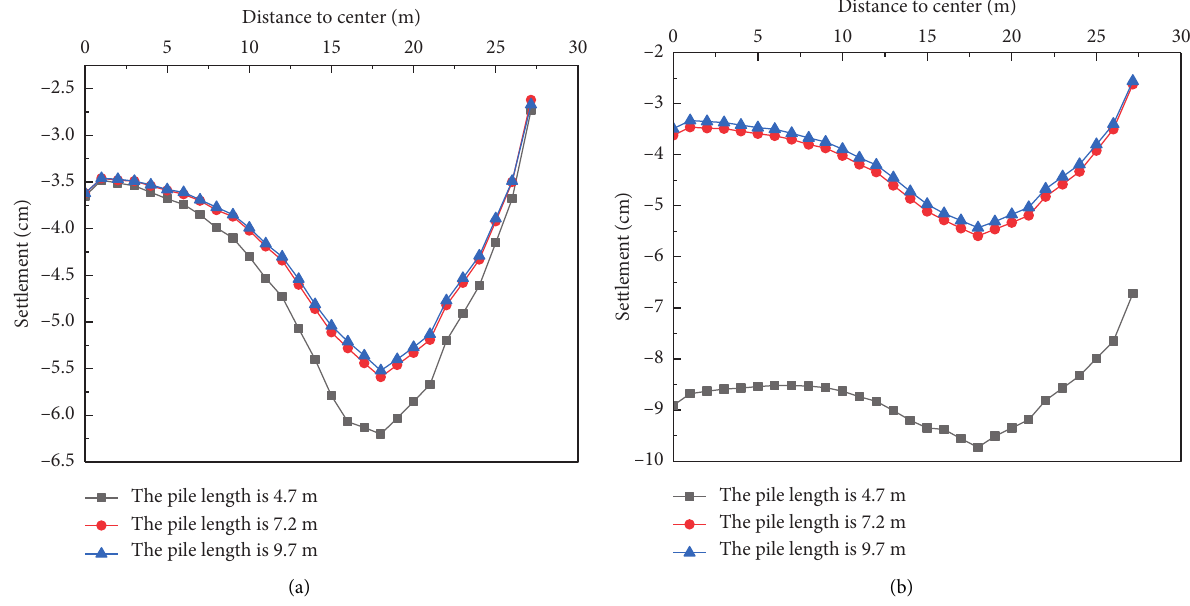
Figure 16: Postconstruction settlement diagram of the foundation surface under different piles lengths. (a) Varying the pile length under the existing road slope. (b) Varying the pile length under the existing subgrade and new embankment.